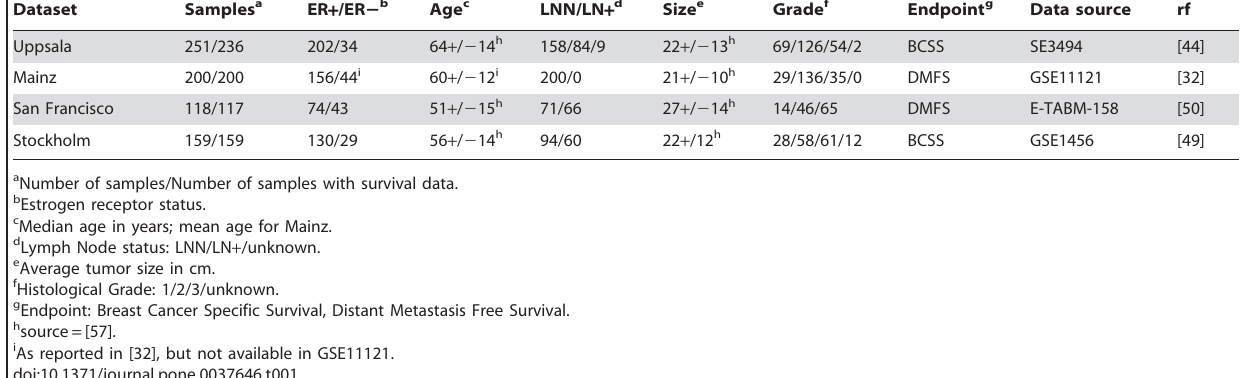
Table 1. Datasets.